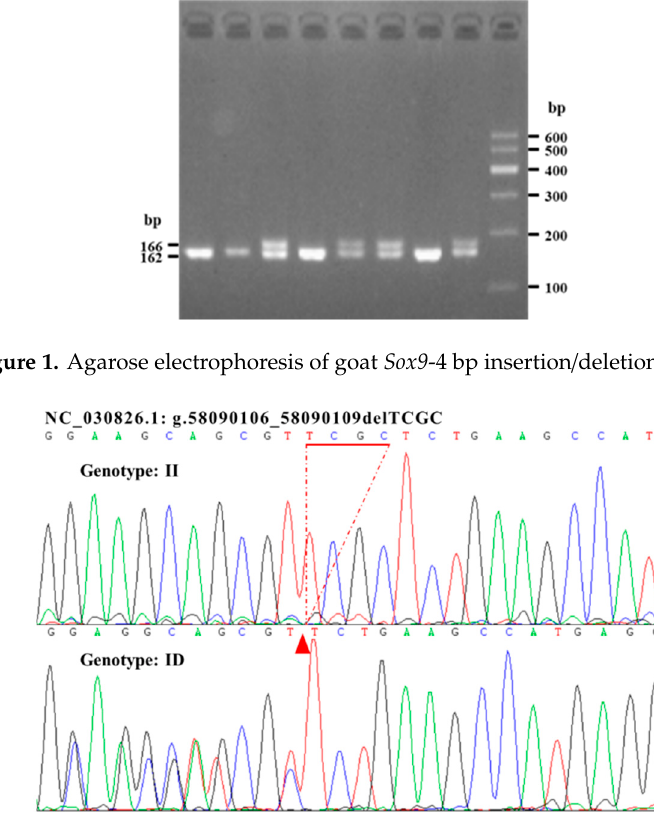
Figure 2. The sequencing chromas for the 4 bp indel in the goat Sox9 gene. Sequencing chromas showed homozygotic insertion type (II) and heterozygote type (ID).